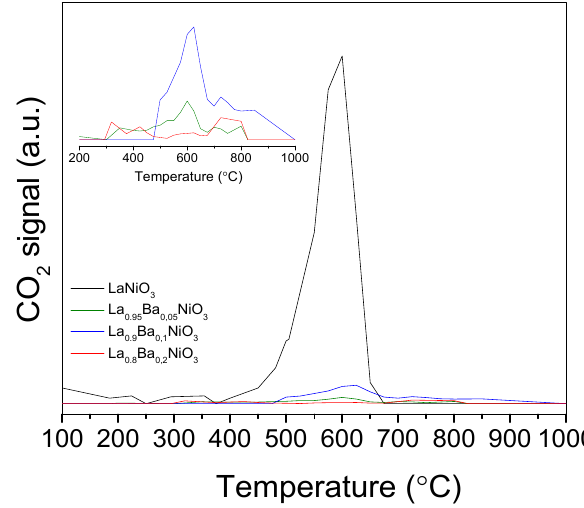
Figure 9. Temperature programmed oxidation under air flow of spent catalysts.